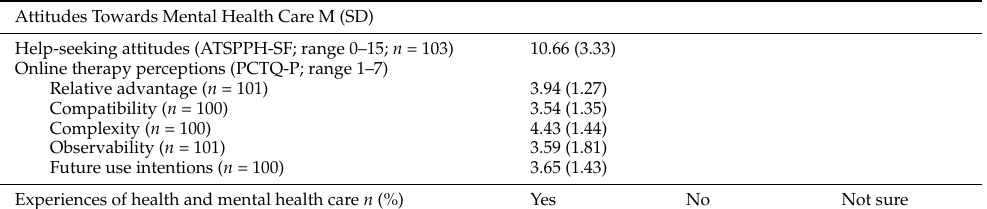
Table 2. Attitudes towards and experiences of health and mental health care quantitative ( N =